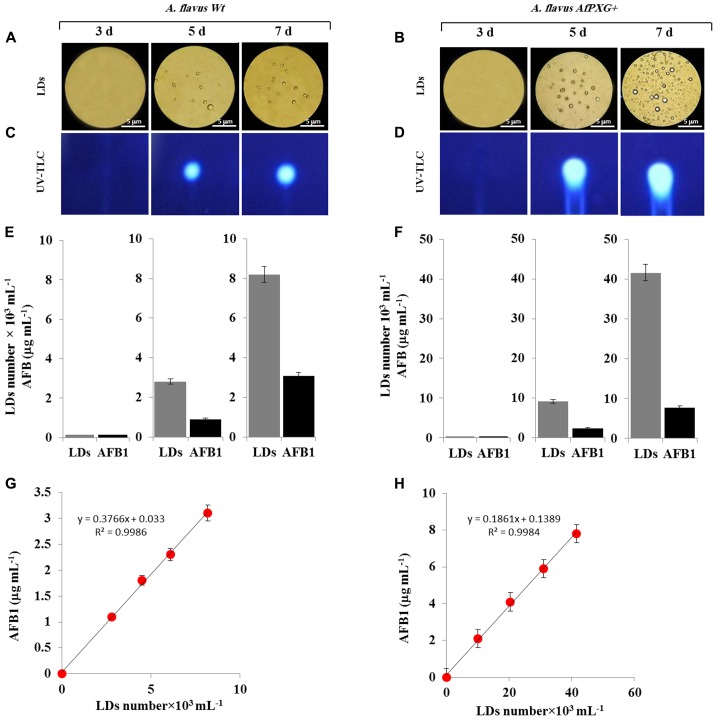
Purified and stable lipid droplets (LDs) isolated from the line AfPXG+ effectively sequester AF. (A,B) Light micrographs of isolated LDs from fungal tissue of A. flavus WT or A. flavus AfPXG+ line, respectively, on days 3, 5, and 7. Purified LDs suspended in 100 mM potassium pyrophosphate, pH 7.4 were observed under a LEICA MPS60 microscope and images were taken at a magnification of 40×. Bar represents 5 mm. (C,D) TLC-analysis of AFB1 in LD fractions isolated from WT and AfPXG+ lines. (E,F) Quantitative data for LD number and content of AFB1 in fractions isolated from WT and AfPXG+ lines. (G,H) Linear relationship between the number of LDs and their AFB1 content. AFB1 was extracted and analyzed by UV-HPLC as described in Section “Materials and Methods.” Measurements were done in triplicate. Values are the means ± SD (n = 3).